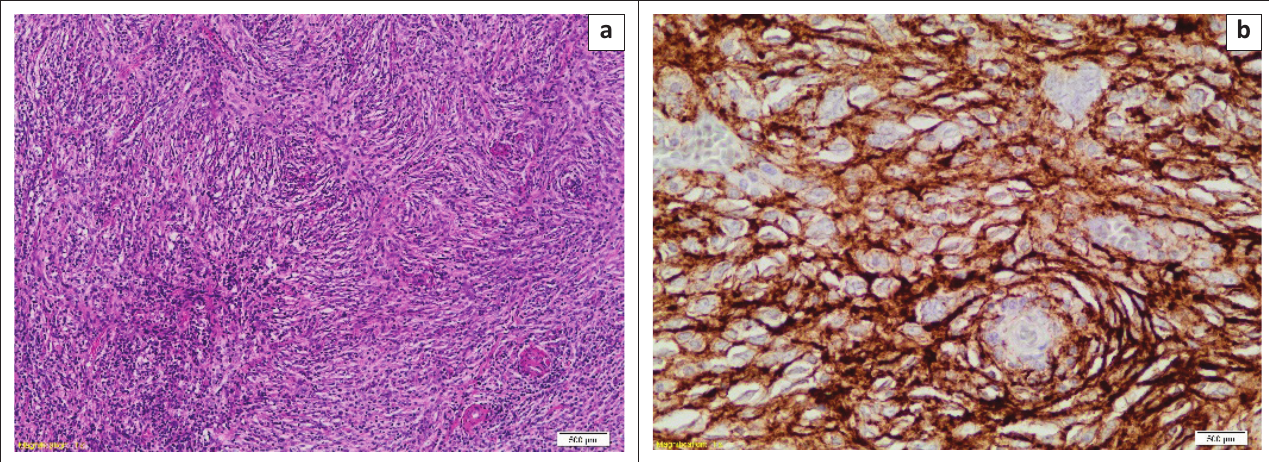
FIGURE 4: Follicular dendritic cell sarcoma of the left tonsil: (a) The tumour appears very cellular, displaying a typical storiform and whorled growth pattern (haematoxylin and eosin, 100×); (b) By immunohistochemistry, the tumour shows diffuse membranous positivity with follicular dendritic cell markers D2-40 (haematoxylin and eosin, 400×), as well as CD21, CD23, CD35 (not